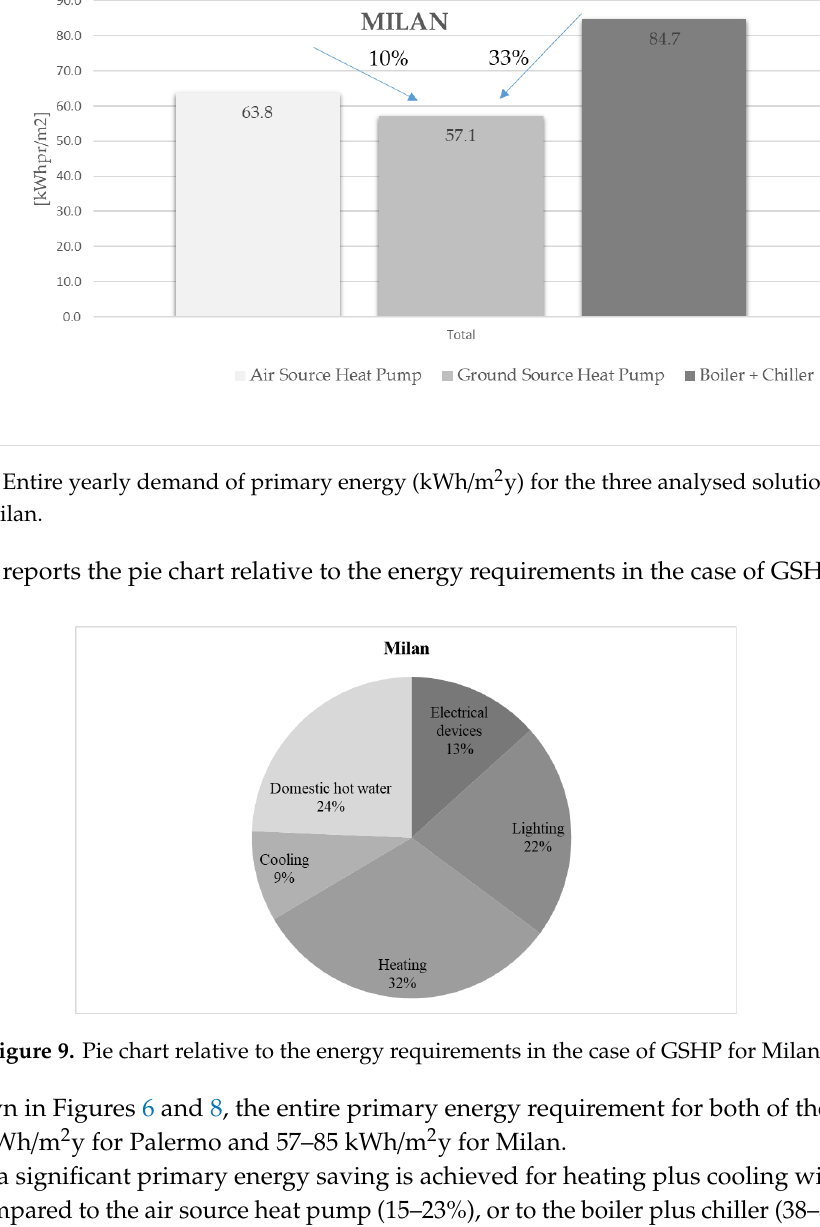
Figure 9. Pie chart relative to the energy requirements in the case of GSHP for Milan.